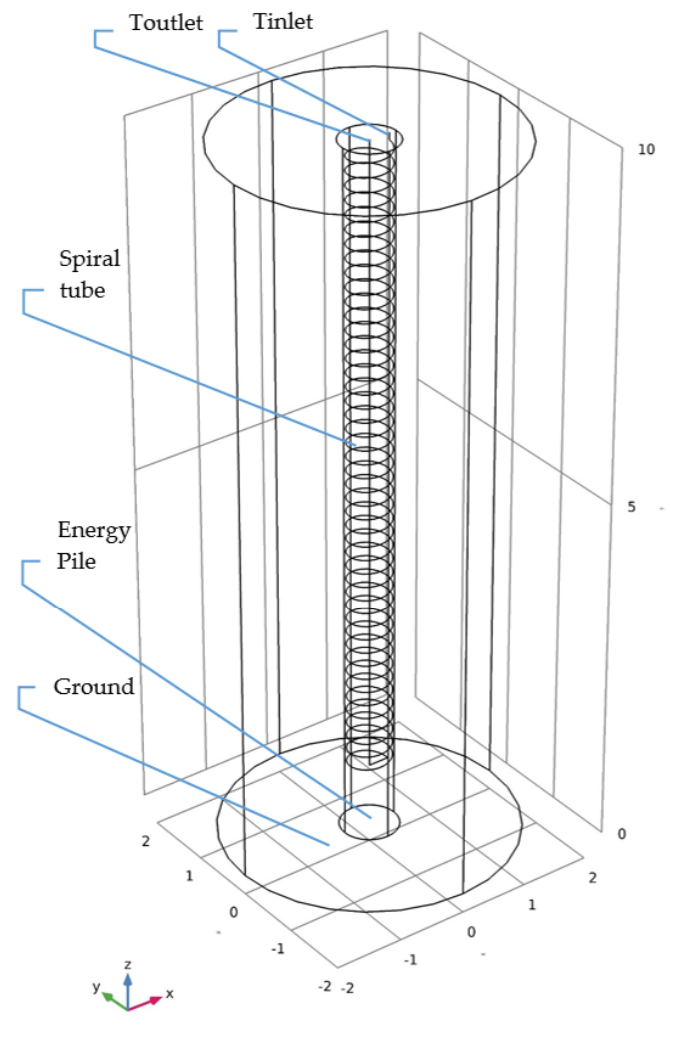
Figure 4. Model geometry of energy